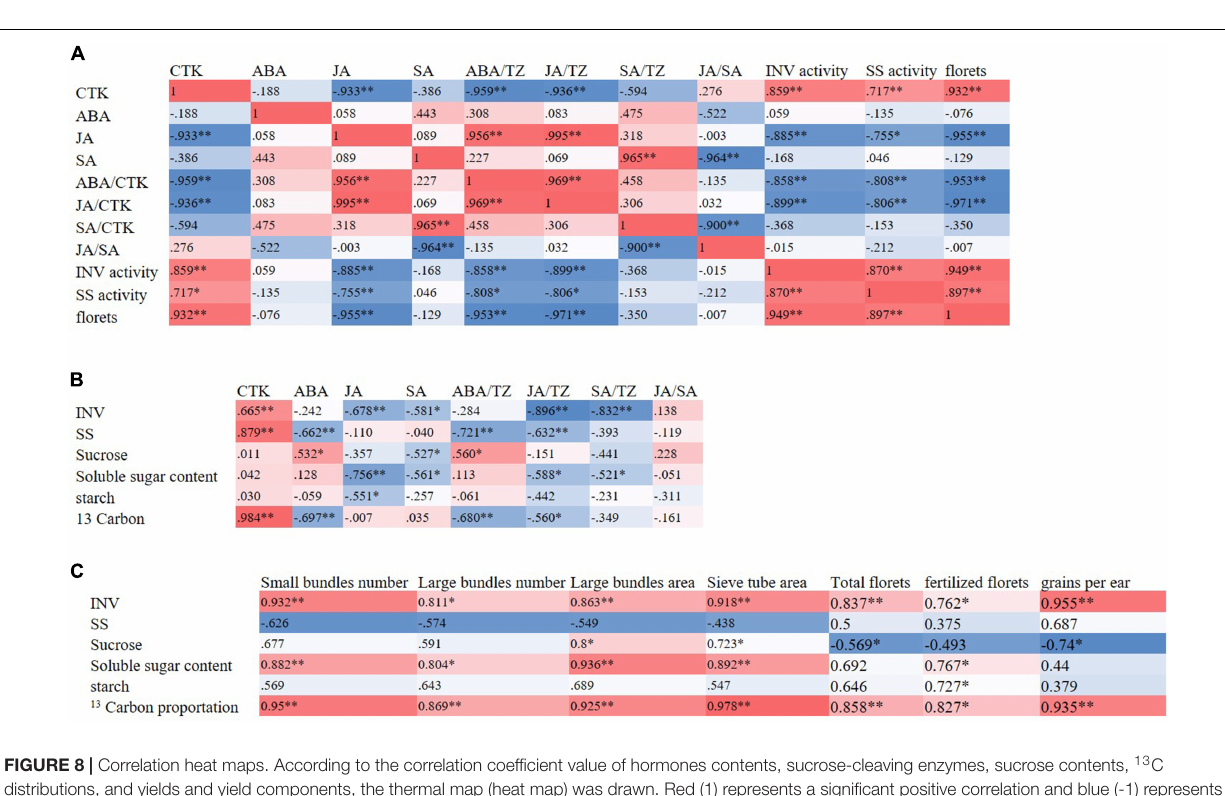
Frontiers in Plant Science |